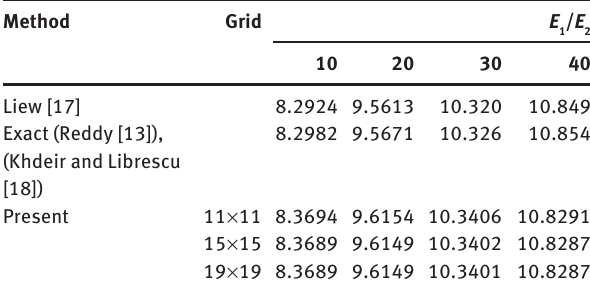
Table 2 The normalized fundamental frequency of the simply supported cross-ply laminated square plate [0 ° /90 ° /90 ° /0 ° ]